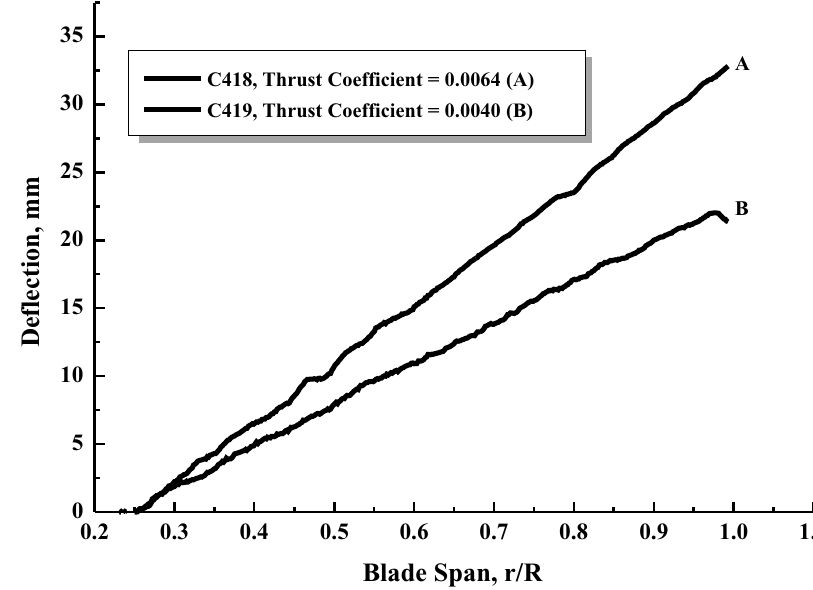
Fig. 11. Effect of rotor thrust coefficient on blade deflection for blade #4, 25% chord, Ψ = 90 ◦ .